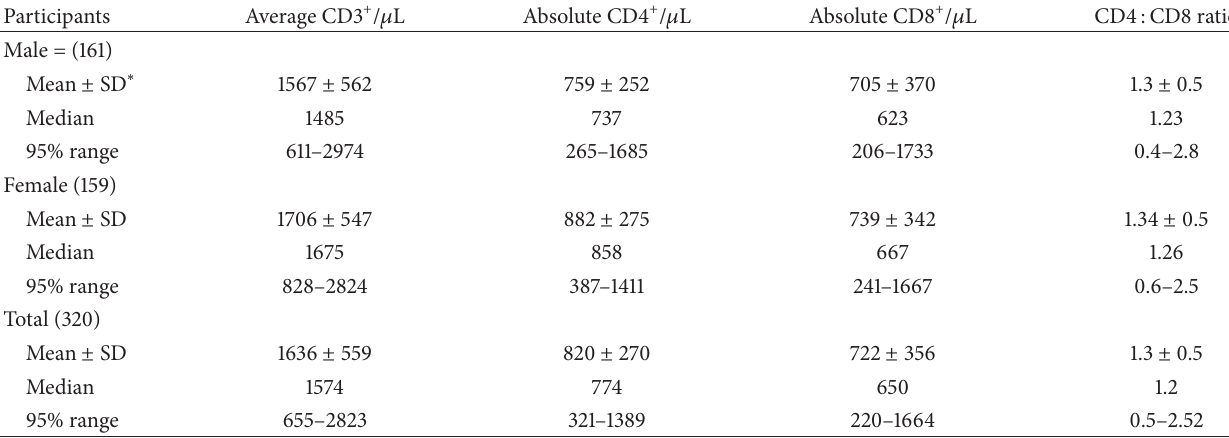
Table 2: Means, medians, and 95th percentile reference intervals of CD3 + , CD4 + , CD8 + , and CD4 to CD8 ratio of HIV negative adults who visited VCT, University of Gondar Hospital, Ethiopia, 2013.